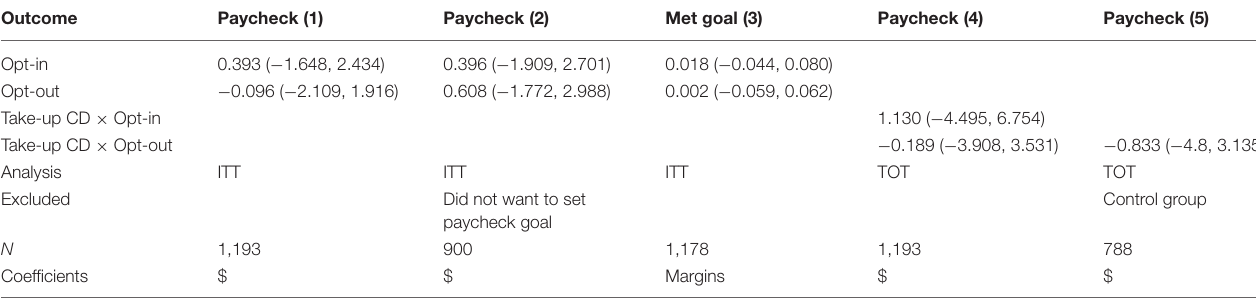
TABLE 3 | Commitment device and student paycheck